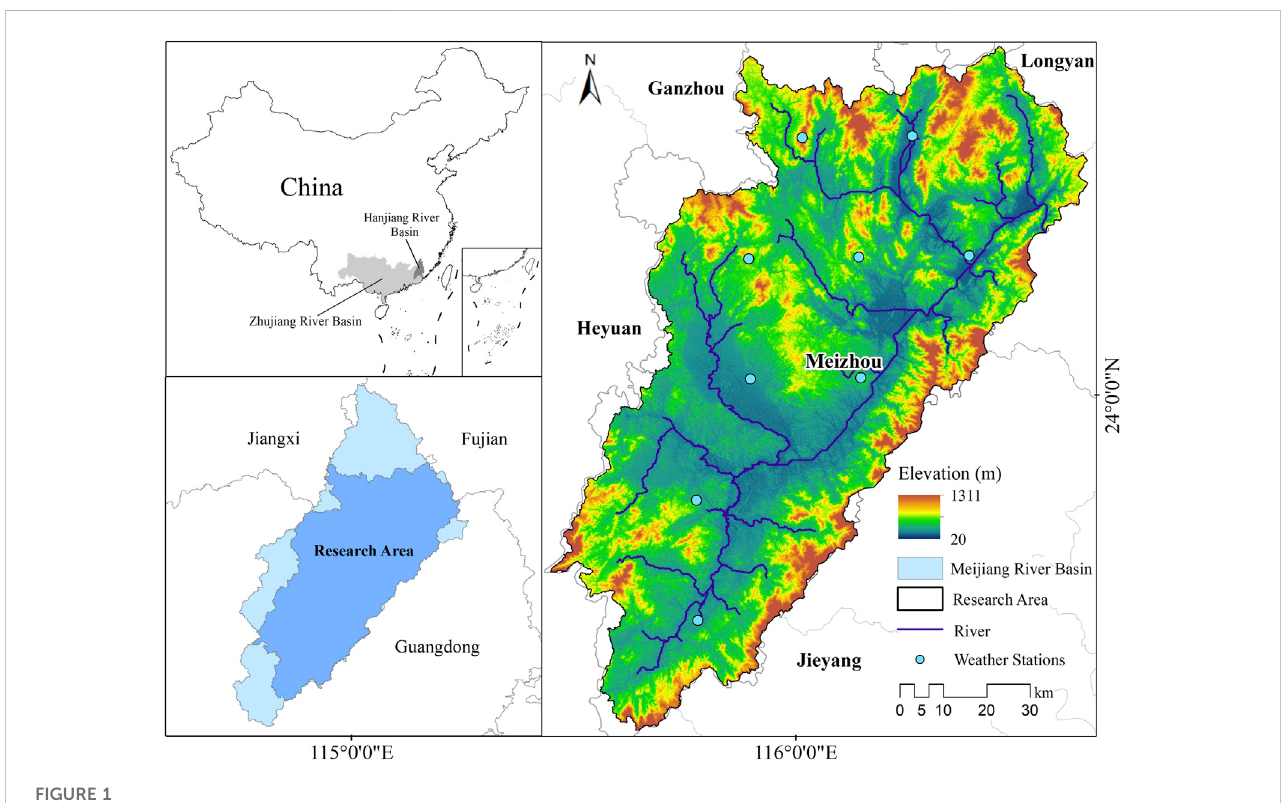
FIGURE 1 Location of the study